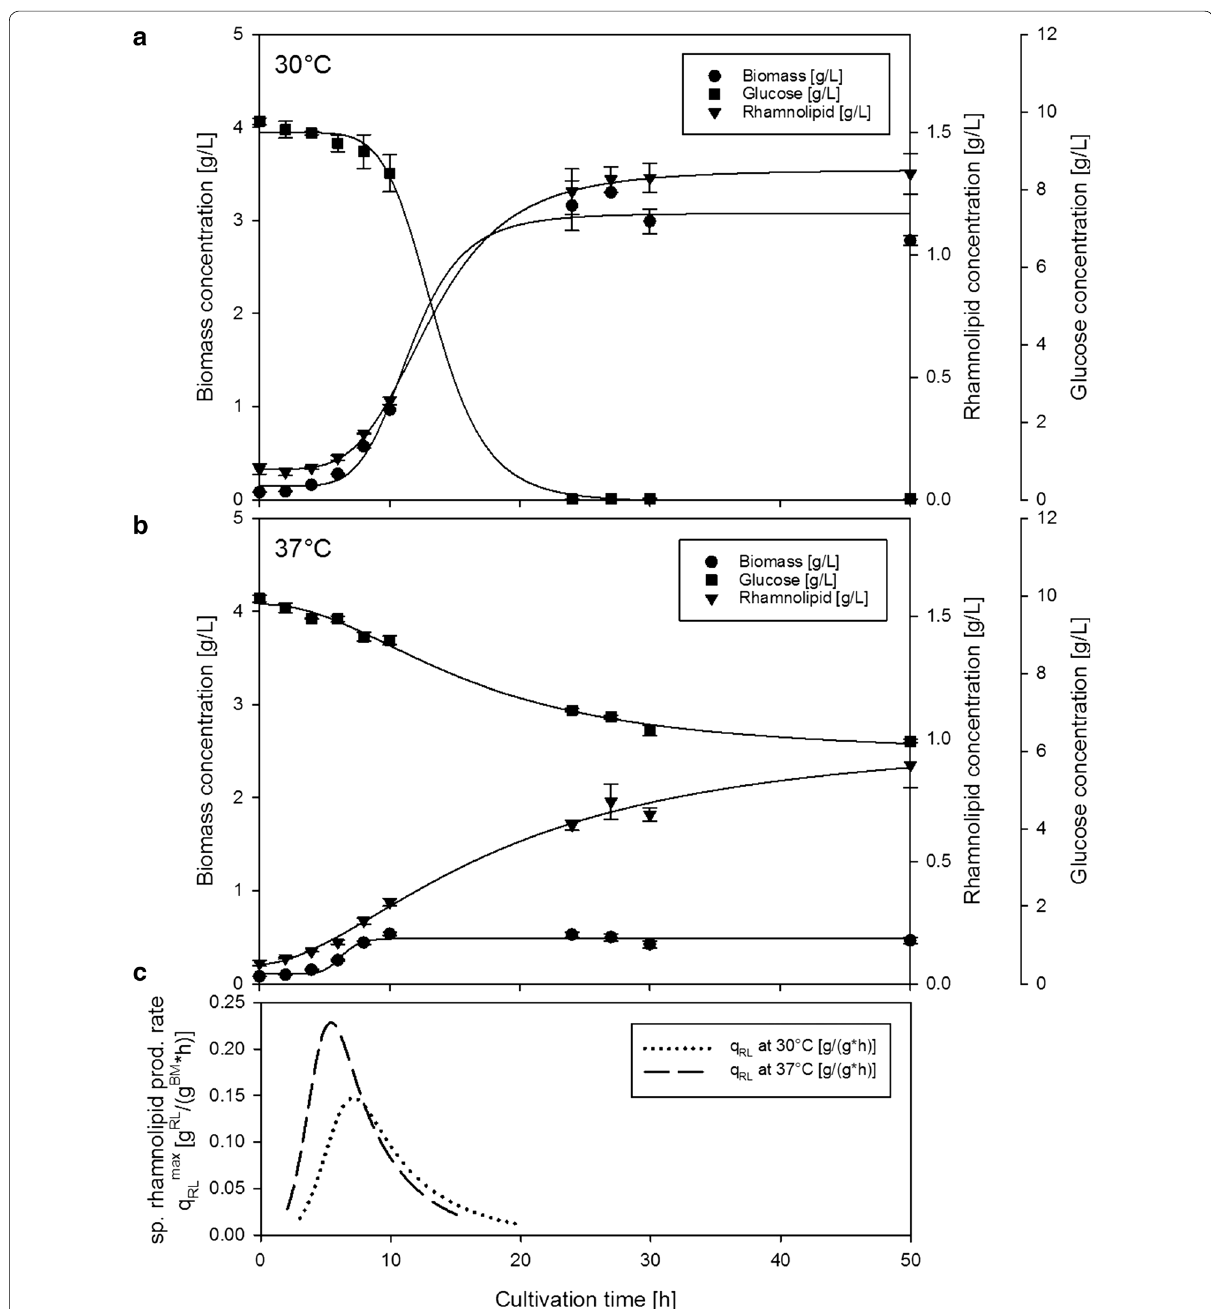
Fig. 2 Time course of biomass concentration (circles), rhamnolipid concentration (triangles) and glucose concentration (squares) during shaking flask cultivation of Pseudomonas putida KT2440 pSynpro8oT_ rhlAB on ModR medium with 10 g/L glucose at 30 °C ( a ) and 37 °C ( b ), and corresponding course of specific rhamnolipid production rate ( c